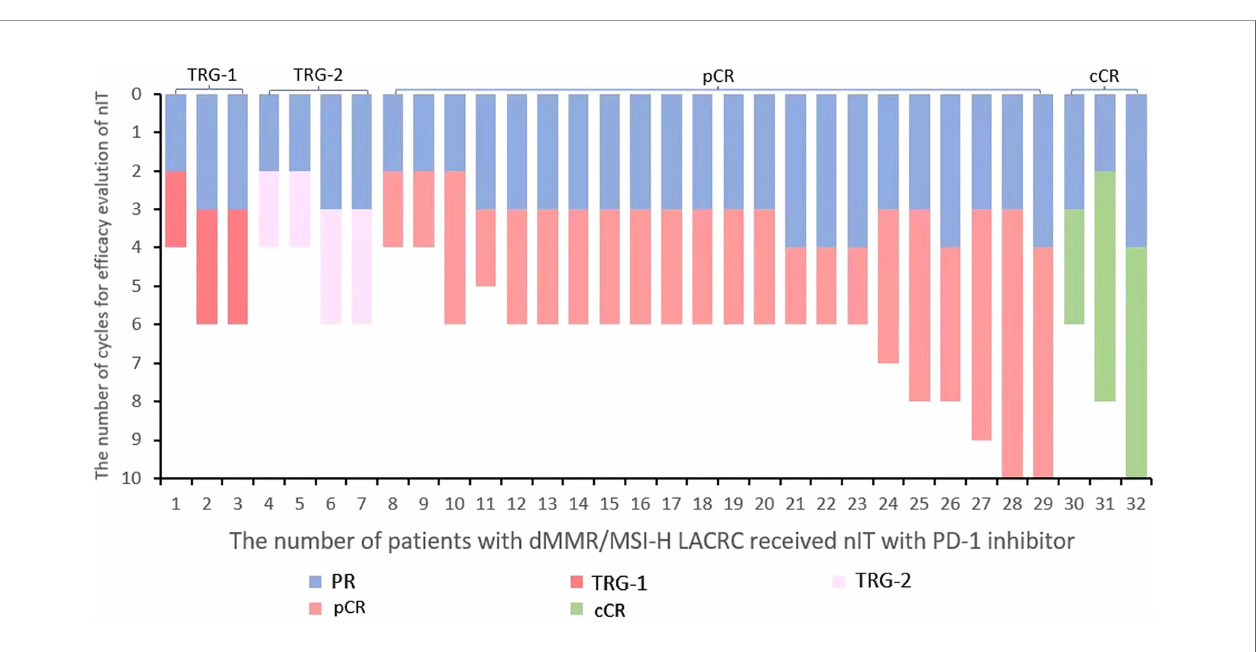
FIGURE 2 | Waterfall plot of ef fi cacy evaluation of nIT in patients with dMMR/MSI-H LACRC. LACRC, Locally advanced colorectal cancer; dMMR, Mismatch repair- de fi cient; MSI-H, Microsatellite instability-high; nIT, Neoadjuvant immunotherapy; PD-1, Programmed cell death protein ⁃ 1; PR, Partial response; pCR, Pathological complete response; cCR, Clinical complete